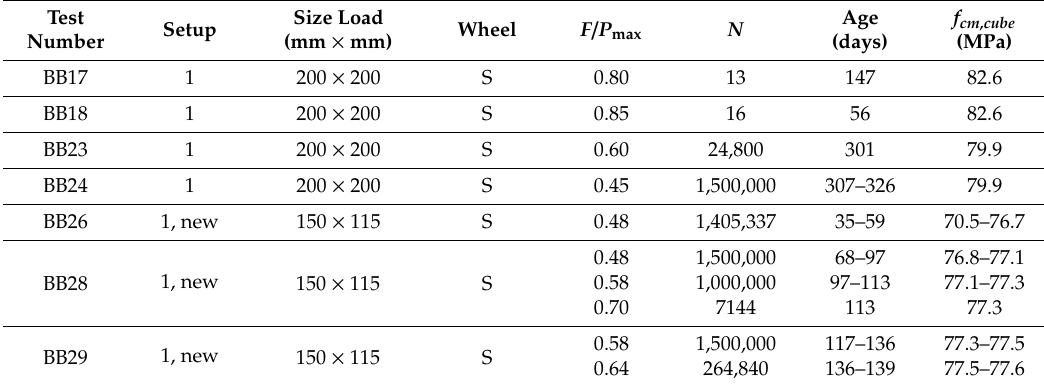
Table 3. Overview of the punching fatigue